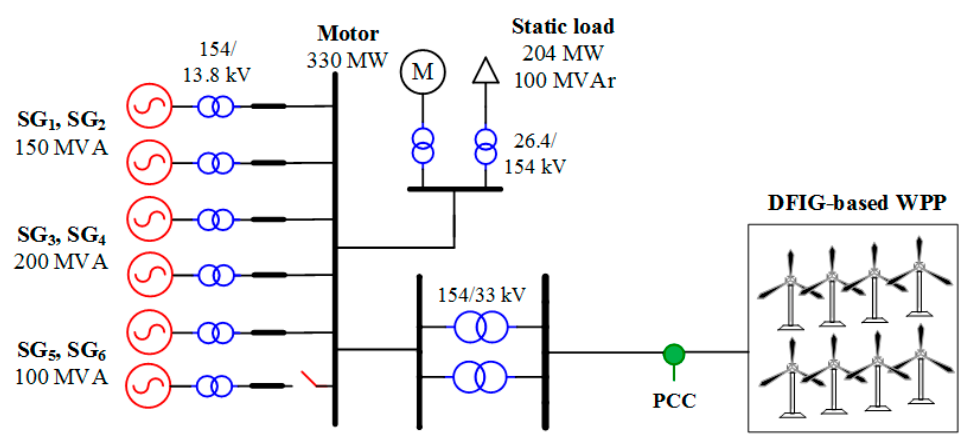
Figure 7. Single line model system with a 100-MW wind power plant.